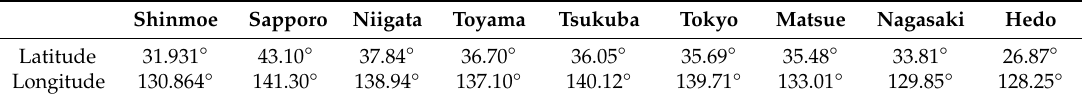
Table 2. Coordinates of Shinmoe-dake and LiDAR sites.